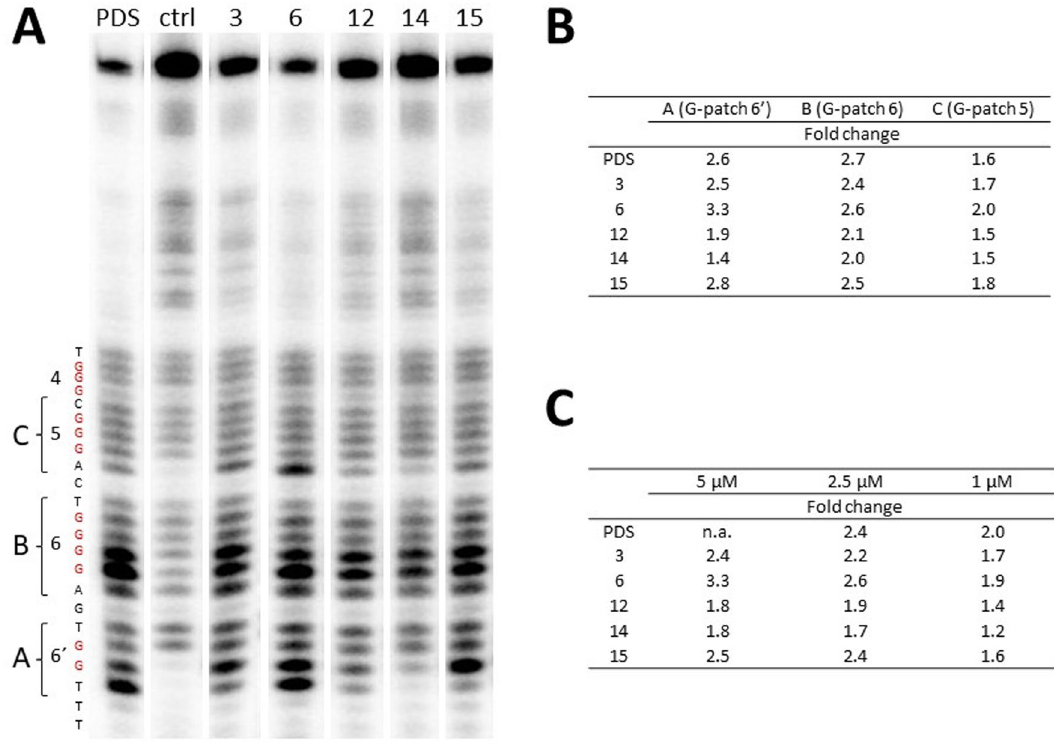
Figure 5. Identification of individual G-tracts stabilized by helquat binding. ( A ) A Taq polymerase stop assay in the presence of 2.5 µM of the compounds being tested, with stop regions visible as bands of higher intensity. The sequence and numbered G-tracts (highlighted in red) are indicated on the left. The brackets labelled with letters A, B and C mark the regions selected for quantification. This figure was made by the excision of selected lines from Supplementary Fig. 2C, which shows the entire original gel. ( B ) Quantification of selected regions, normalized against the negative control (ctrl). The values represent a fold change calculated as ratio between pixel intensity of individual region A (G-patch 6 ′ ), B (G-patch 6) or C (G-patch 5) and pixel intensity of negative control (ctrl) of the same regions. The automatic background subtraction was performed by Rolling Ball method in 1D gel analysis using ImageQuant TL 8.1. ( C ) Quantification of all regions (A, B and C) together at different concentrations (see Supplementary Fig. S2 for gels) normalized against the control.The values represent a fold change calculated as ratio between pixel intensity of all regions (A, B, C) at different concentrations of compounds and pixel intensity of negative control (ctrl) of all regions (A, B, C). The same background subtraction method was used as in ( B ). n.a.—not analysed, PDS (pyridostatin)—positive control.